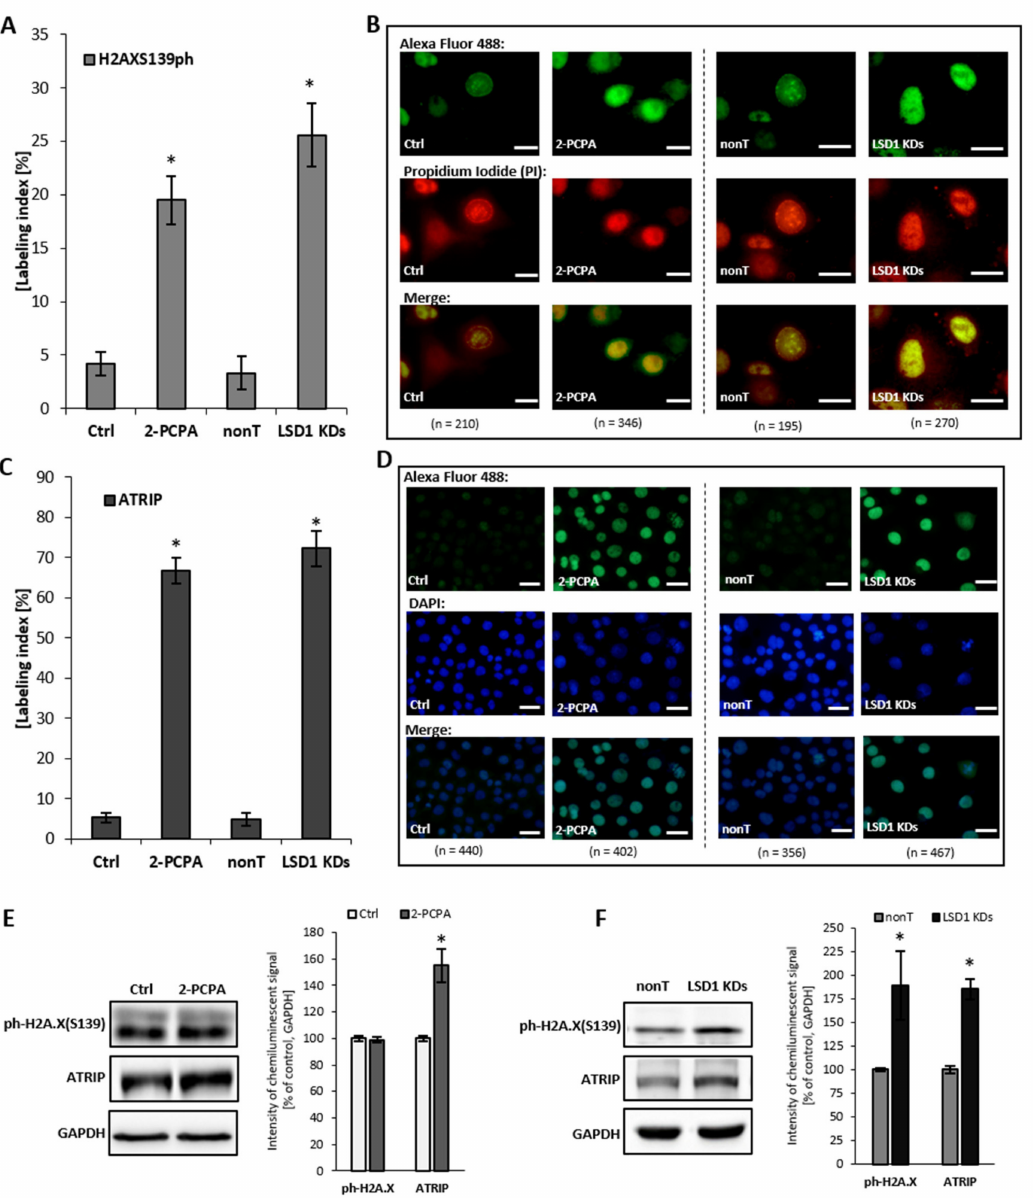
Figure 5. Level of DNA damage markers: H2AXS139ph and ATRIP after shutting down LSD1 activity. ( A – D ) immunofluorescent localization of the antigens, ( E , F ) protein level of markers by Western blotting. Presented images are representative, and the data are the average of three independent experiments. The labeling index was calculated as the ratio of immunofluorescence-labeled cells to all cells in an HMEC-1 cell population. Scale bars are equal to 10 µ m. * p < 0.05, ANOVA and post hoc analysis by Tukey’s